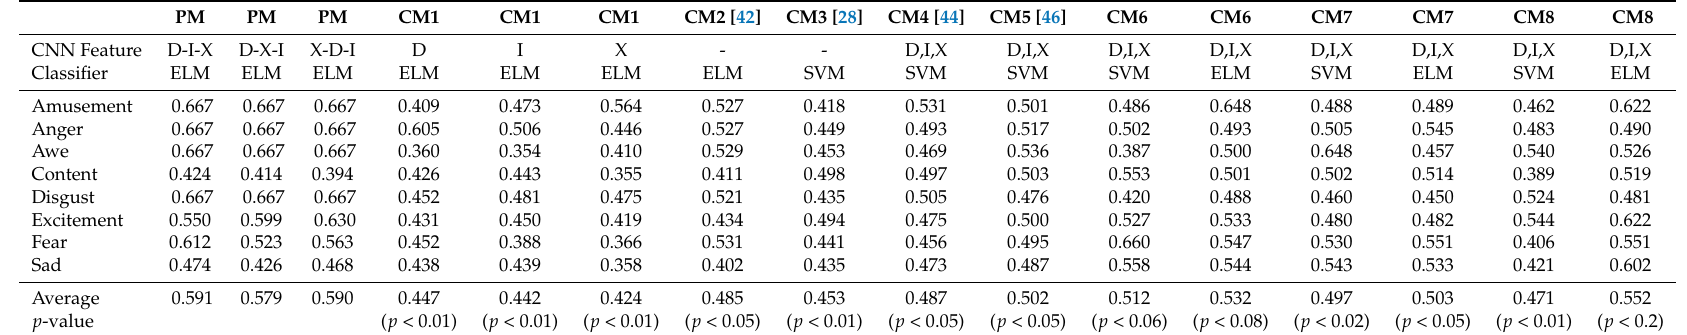
Table 3. Average values of F1-measures of all subjects calculated for each emotional category. Note that • - • - • and • , • , • are different in terms of whether their order is considered or not. p -value was obtained by Welch’s t -test